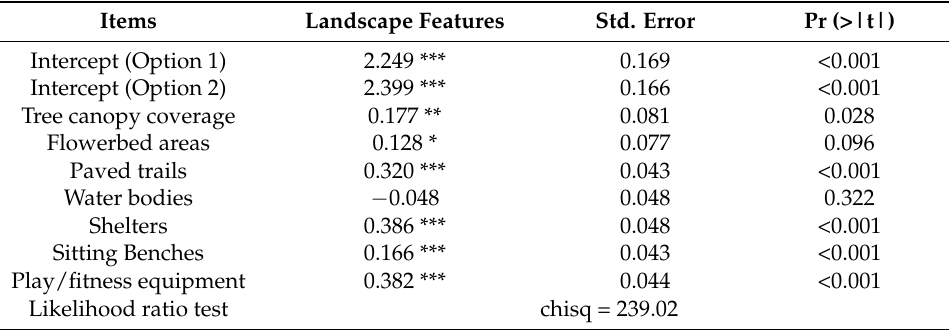
Table 4. The estimates of landscape features on pooled respondents’ visitation